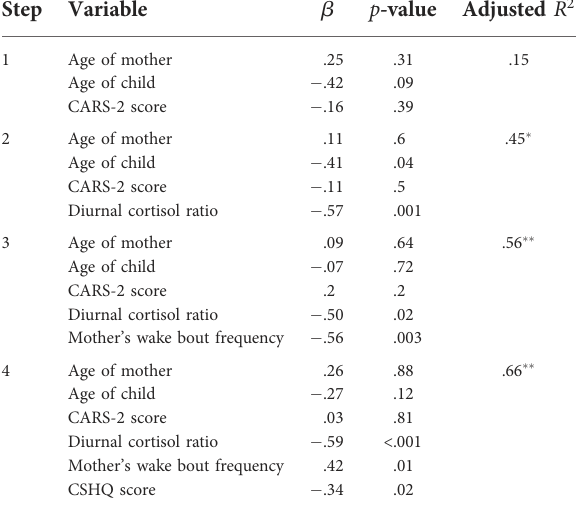
TABLE 11 Hierarchical multiple regression predicting morning cortisol in